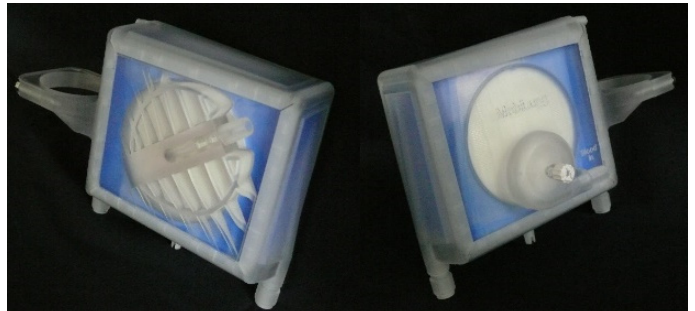
Figure 3. Novel portable, stacked, and centrifugal potted membrane oxygenator front and back.